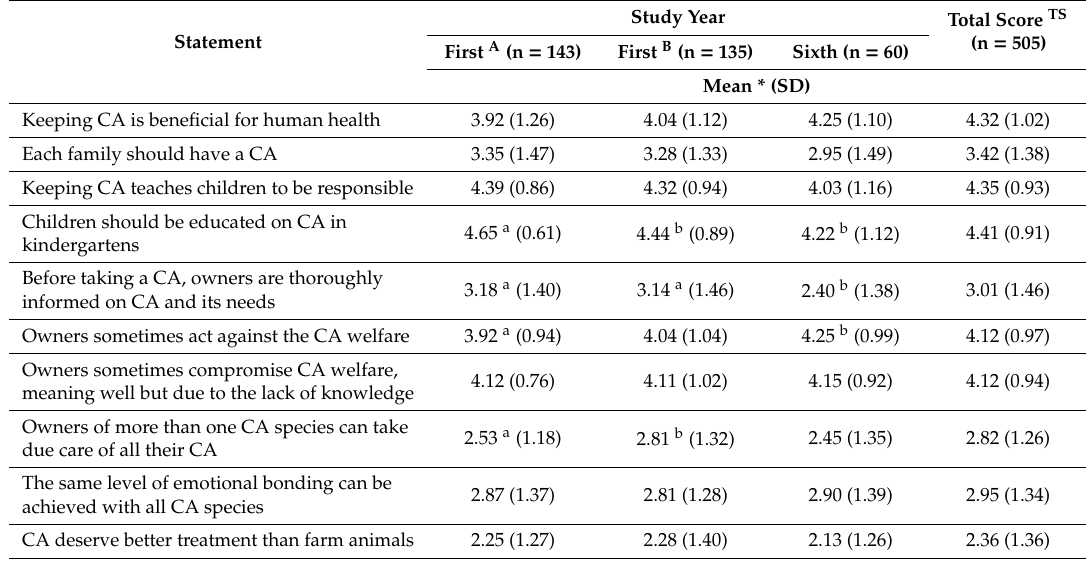
Table 1. Student opinions towards general statements on companion animals.